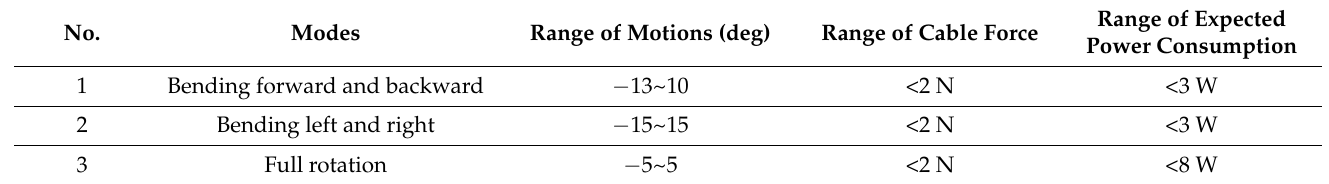
Figure 7. Schemes for joystick-controlled motions of the LARMbot torso: ( a ) bending forward and backward; ( b ) bending left and right; ( c ) full rotation. Table 2. Testing modes for experimental performance characterization of LARMbot torso V1.